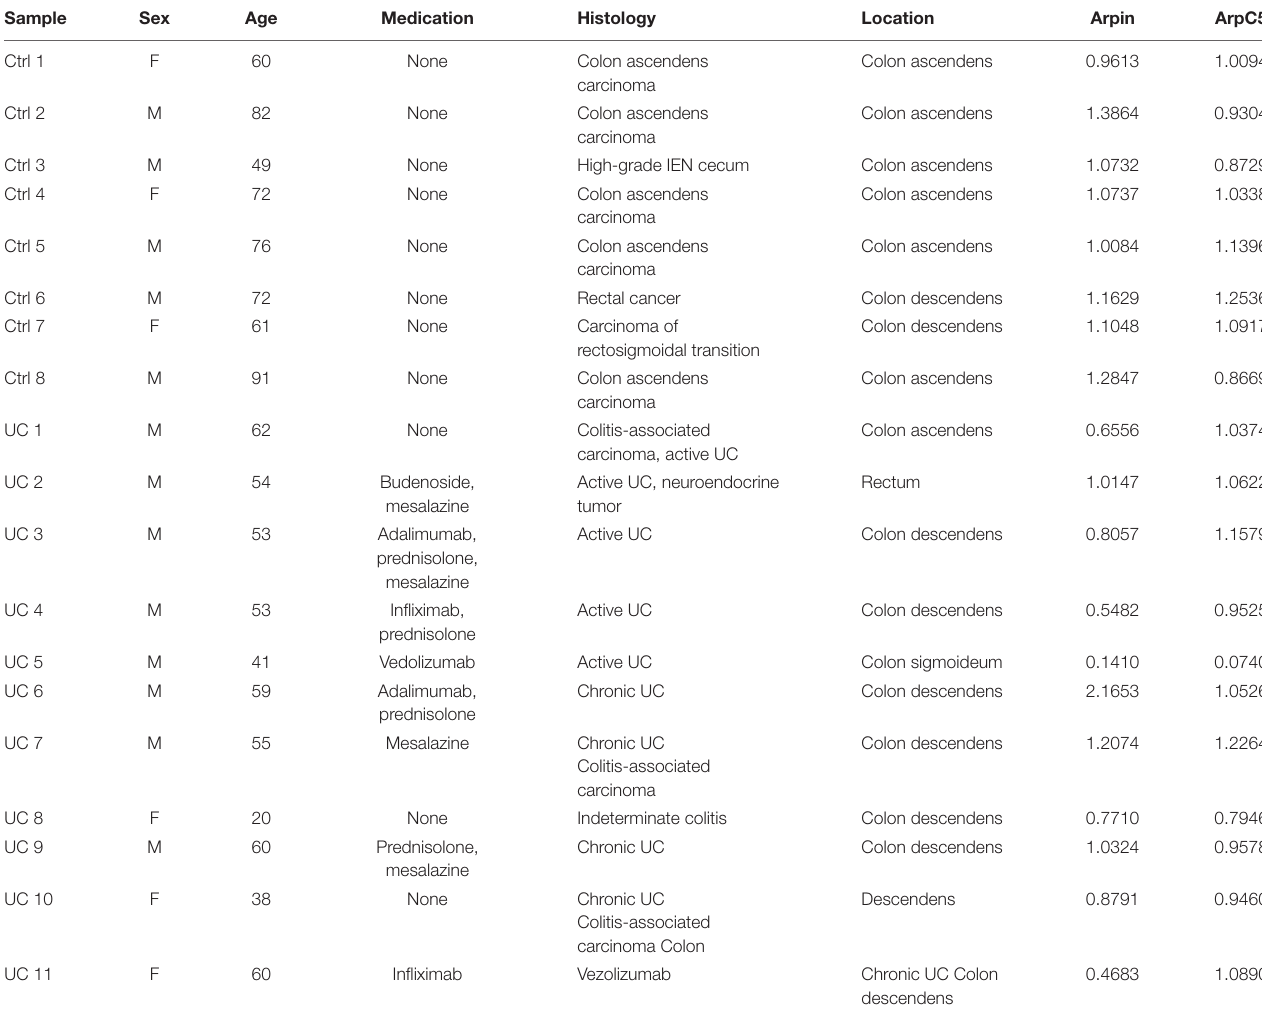
TABLE 1 | Clinical data from control and ulcerative colitis (UC) patients.